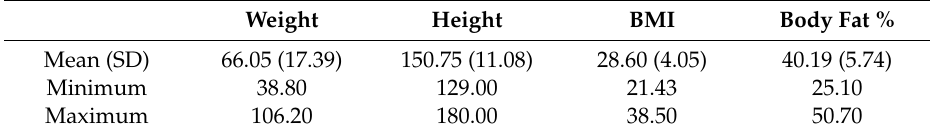
Table 1. Descriptive sample characteristics ( n = 25) based on bioimpedance test